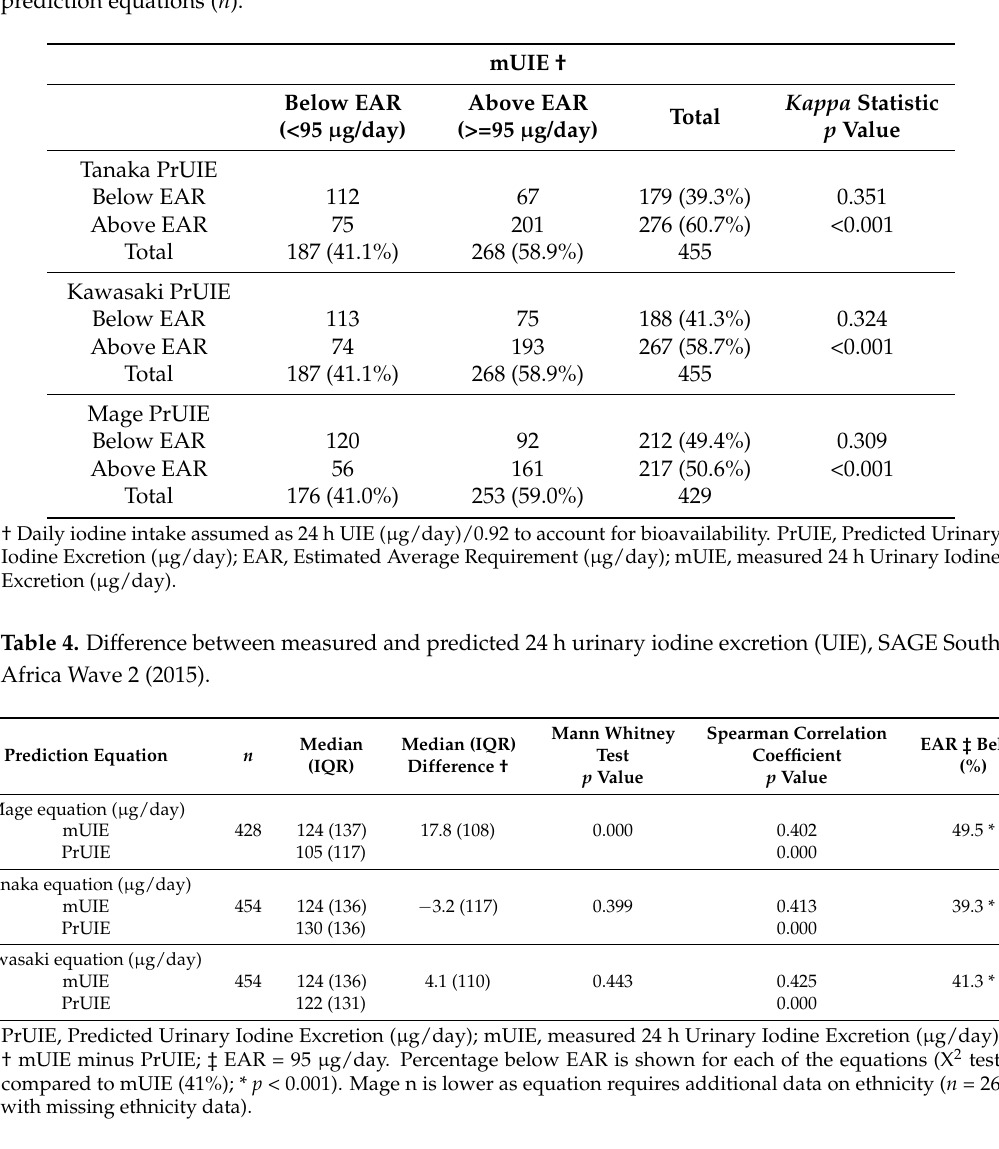
Table 3. Agreement between measured (mUIE) and Predicted (PrUIE) urinary iodine excretion using prediction equations ( n ).